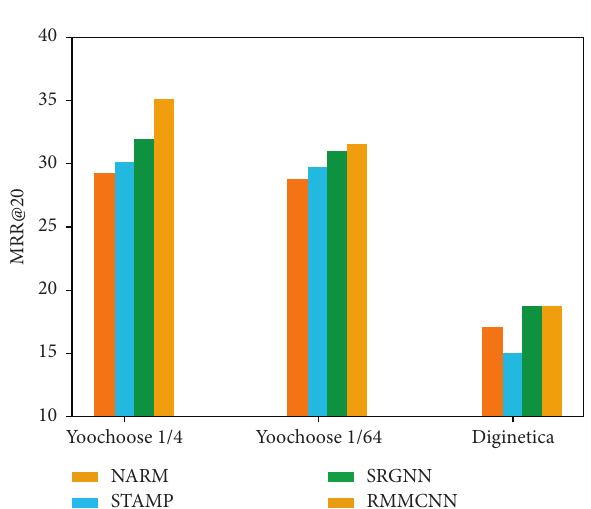
Figure 4: P@20 of different connection